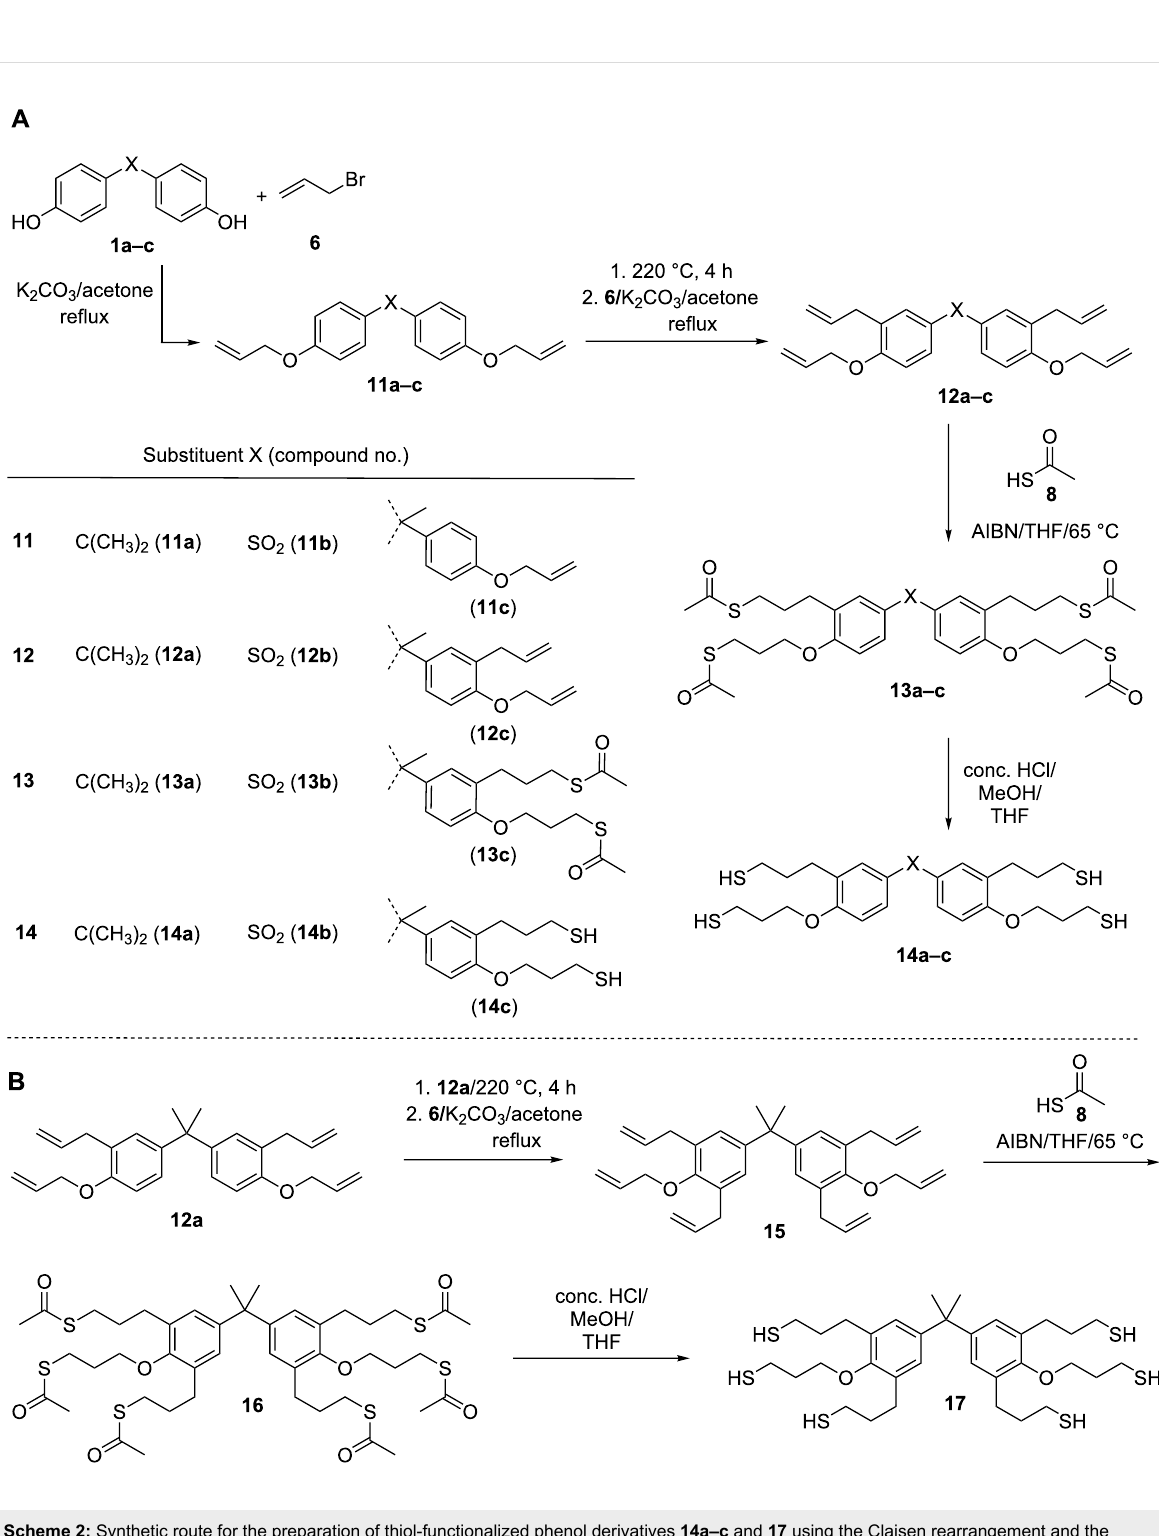
Scheme 2: Synthetic route for the preparation of thiol-functionalized phenol derivatives 14a–c and 17 using the Claisen rearrangement and the radical addition of thioacetic acid as key steps.